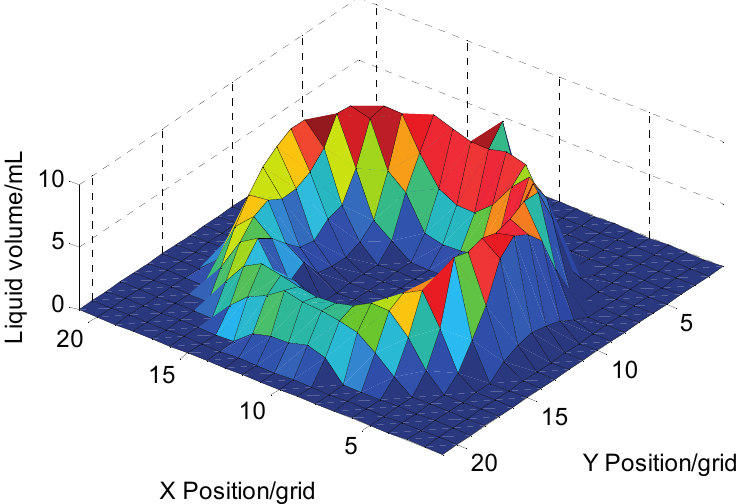
Figure 8. Two-dimensional flow distribution measurement result of a nozzle of Teejet AITXA 8004.